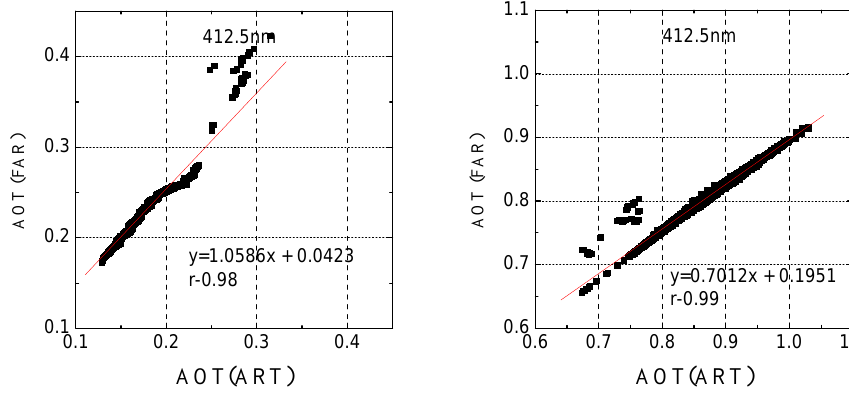
Fig. 12. Correlation between values of AOT at 412.5nm retrieved with the FAR and ART codes.